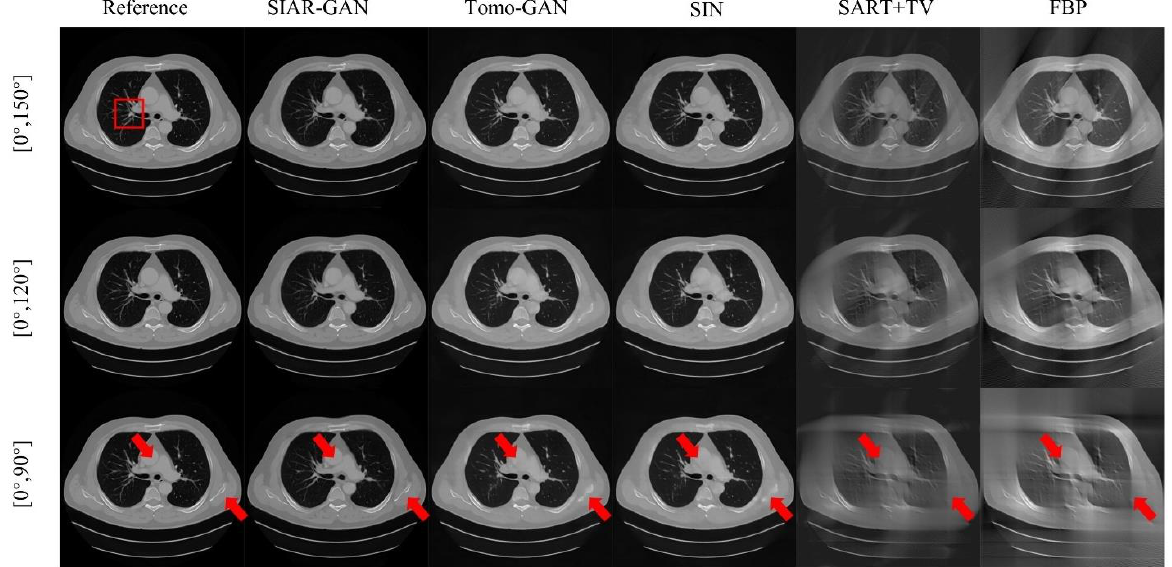
Figure 7. Experimental results on lung CT data. The first, second, and third rows are the results of reconstruction from [0 , 150 ] , [0 , 120 ] , and [0 , 90 ] projection data. The first column is the full-angle reconstructed reference image, and the images in the subsequent columns are SIAR-GAN, Tomo-GAN, SIN, SART-TV and FBP reconstruction results. (Best viewed with